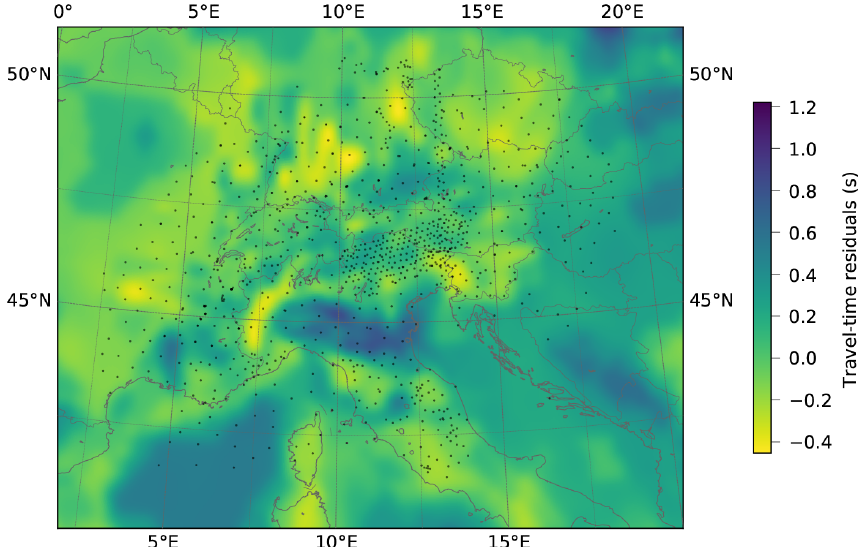
Figure A2. Vertically stacked travel-time residuals of crustal model compared to reference minimum 1D model of D09a, showing the potential crustal contributions on teleseismic travel-time residuals. The most prominent features are the high-velocity anomaly in the western Alps (Ivrea body) and the low-velocity anomaly of the Po plain. Low velocities of Molasse sediments are compensated by higher velocities in the crust of the Diehl